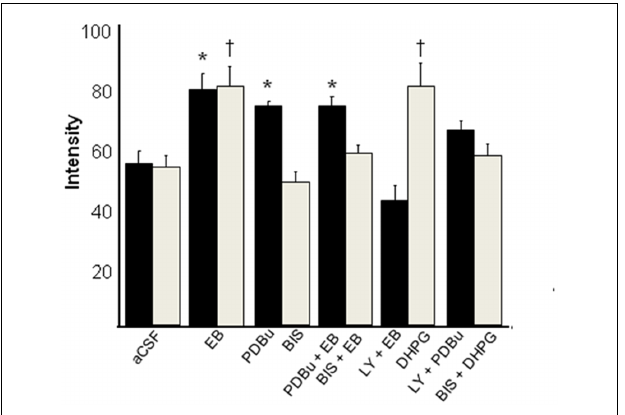
FIGURE 4 | Estradiol-induced μ -opioid receptor (MOR) internalization in the medial preoptic nucleus (MPN) is dependent on protein kinase C θ (PKC θ ) activation in the arcuate nucleus of the hypothalamus (ARH). This graph represents two experiments: animals infused with a PKC inhibitor, bisindolylmaleimide (BIS; 50nmol, gray bars), and animals infused with a PKC activator, phorbol 12,13-dibutyrate (PDBu; 25nmol, black bars). Animals sacrificed 30min after EB injections displayed a significant increase in MOR internalization compared to oil injected animals. Antagonizing with BIS attenuated this EB-induced MOR internalization in the MPN. PDBu did not increase the level of internalization above that seen in EB-only treated animals. However the PKC activator did induced MOR internalization in the absence of EB treatment suggesting that estradiol and PDBu act through the same signaling pathway.The mGluR1 antagonist (LY367385) and agonist (DHPG) were also infused in combination with BIS or PDBu to determine whether PKC activation was downstream of ER/mGluR1 signaling.These data correlate with behavioral data that show that rats treated with BIS before EB were less receptive than aCSF-treated, EB-primed rats, and that PDBu did not induce lordosis behavior in animals that were not treated with a sub-behavioral dose of EB (2 μ g; Dewing et al., 2008;Yildirim et al., 2008). * = statistical significance at the p < 0.05